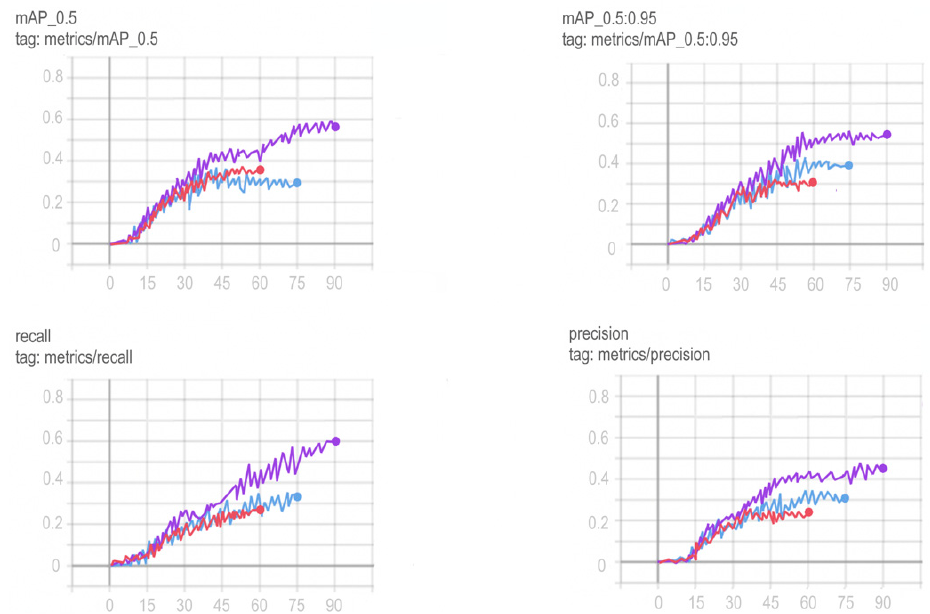
Figure 15. Comparison of training ResNeXt at 60 (red graph), 75 (blue graph) and 90 (purple graph) epochs.